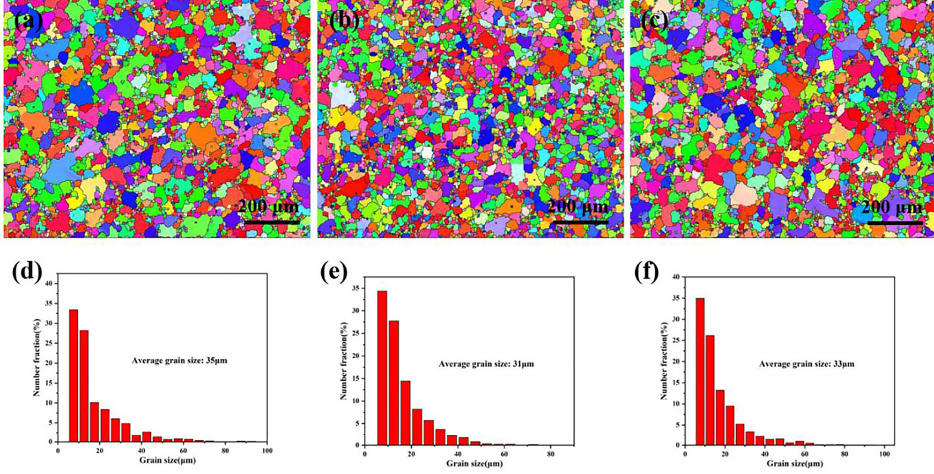
Figure 9. EBSD analysis and average grain size statistics of as-extruded Al-9.5Si-1.5Cu-0.8Mn-0.6Mg alloy: ( a , d ) C0 alloy; ( b , e ) C1 alloy; ( c , f ) C2 alloy.